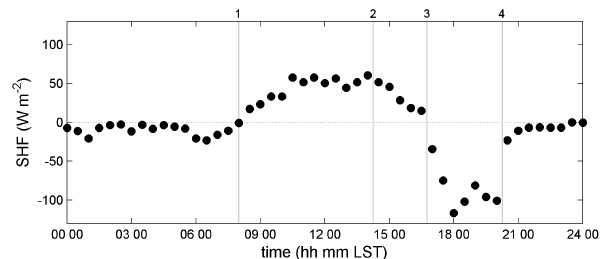
Figure 11. Vertical sensible heat flux (SHF) for 23 August 2001, from eddy covariance analysis of ultrasonic anemometer measure- ments (averaging interval: 30min) collected at RON2. The vertical grey lines indicate (1) beginning of the morning heating, (2) be- ginning of the SHF decrease at the arrival of the Ora del Garda, (3) shift to negative SHF and (4) end of the phase characterized by large negative SHF.